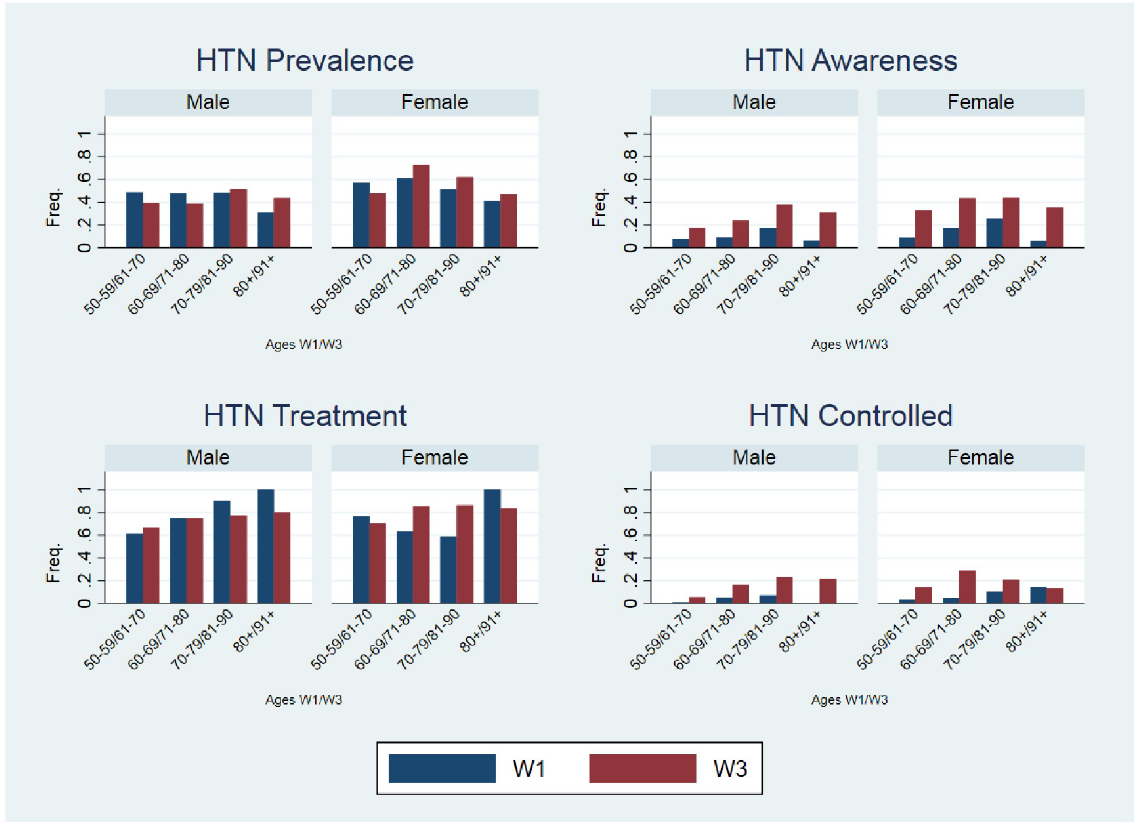
Fig 4. Top left hypertension prevalence (W1 n = 426, W3 n = 400), top right hypertension awareness (W1 n = 95, W3 n = 245), bottom left hypertension treatment (W1 n = 66, W3 n = 187), and bottom right hypertension control (W1 n = 18, W3 n = 99).